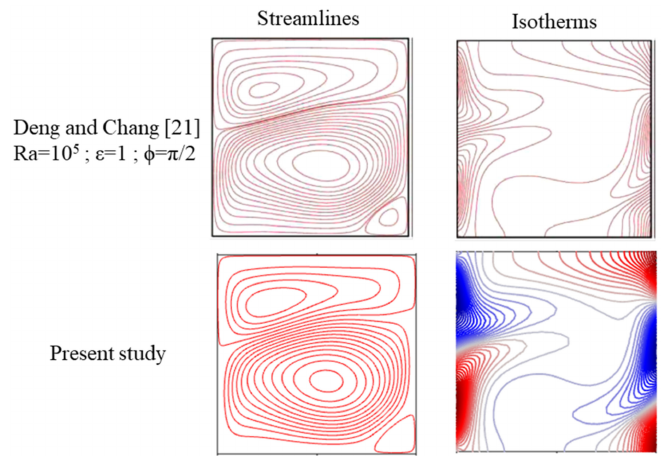
Figure 4. Results